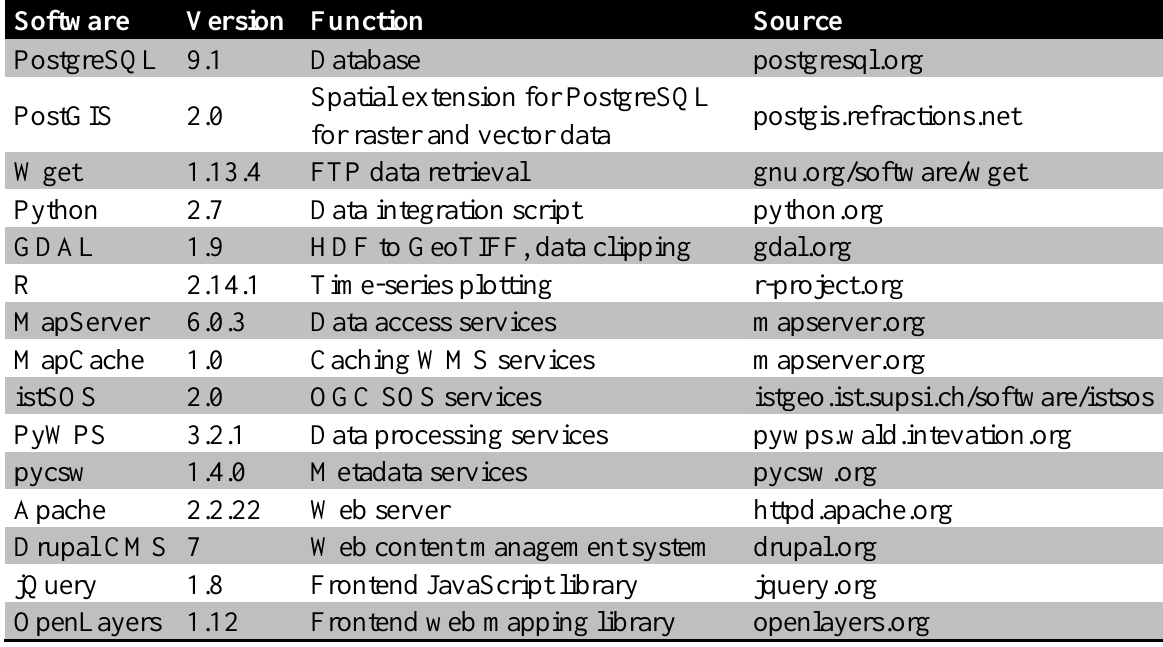
Table 4. Open-source tools used for the developed